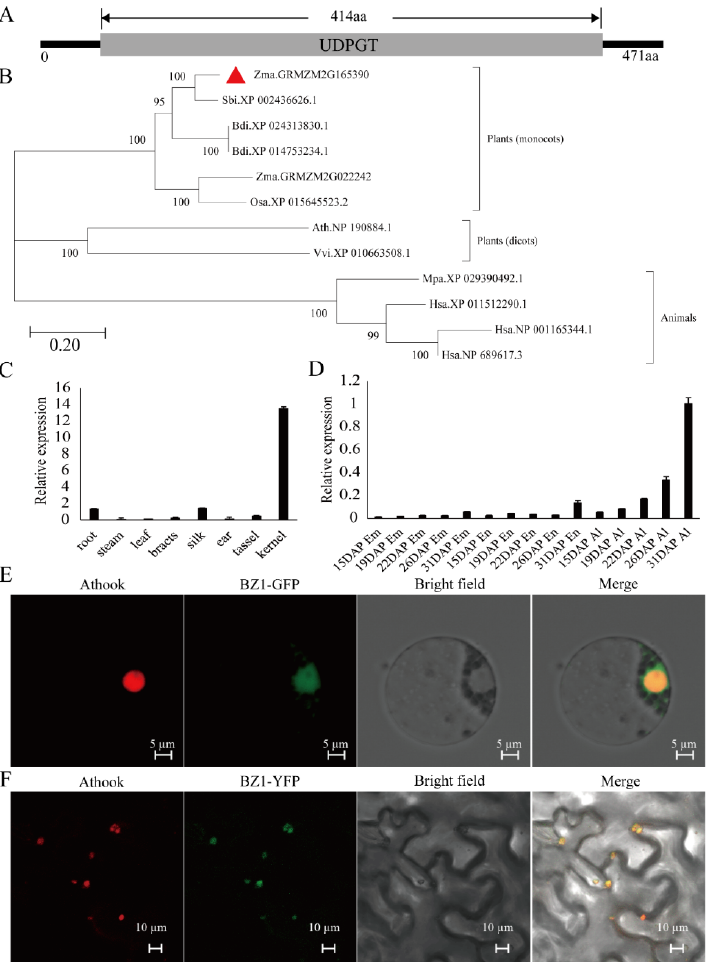
Figure 3. Phylogenetic analysis, spatial and temporal expression profile and subcellular localization of ZmBZ1. ( A ) Protein structure of ZmBZ1; ( B ) Phylogenetic analysis of ZmBZ1 and its homologs in different species. Red triangle protruding ZmBZ1. Bar = 0.2 substitutions per amino acid position; ( C , D ) Spatial and temporal expression profile of ZmBZ1 analyzed via qPCR in various tissues ( C ) and during seed development ( D ). GAPDH was used as an internal control. Values are shown as means ± SE, n = 3; ( E , F ) Subcellular localization of ZmBZ1 protein in maize leaf protoplasts ( E ) and tobacco leaf epidermal cells ( F ). GFP, green fluorescence protein; YFP, yellow fluorescence protein; Athook, a nuclear marker. Bar = 5 μ m and 10 μ m.